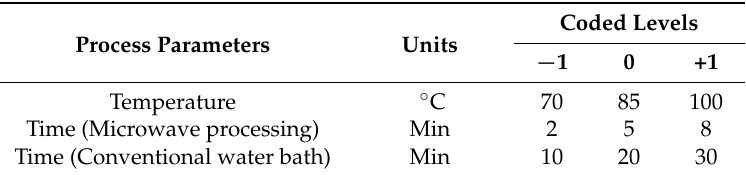
Table 2. Central composite design for processing of soymilk with independent variables and their coded and actual values.